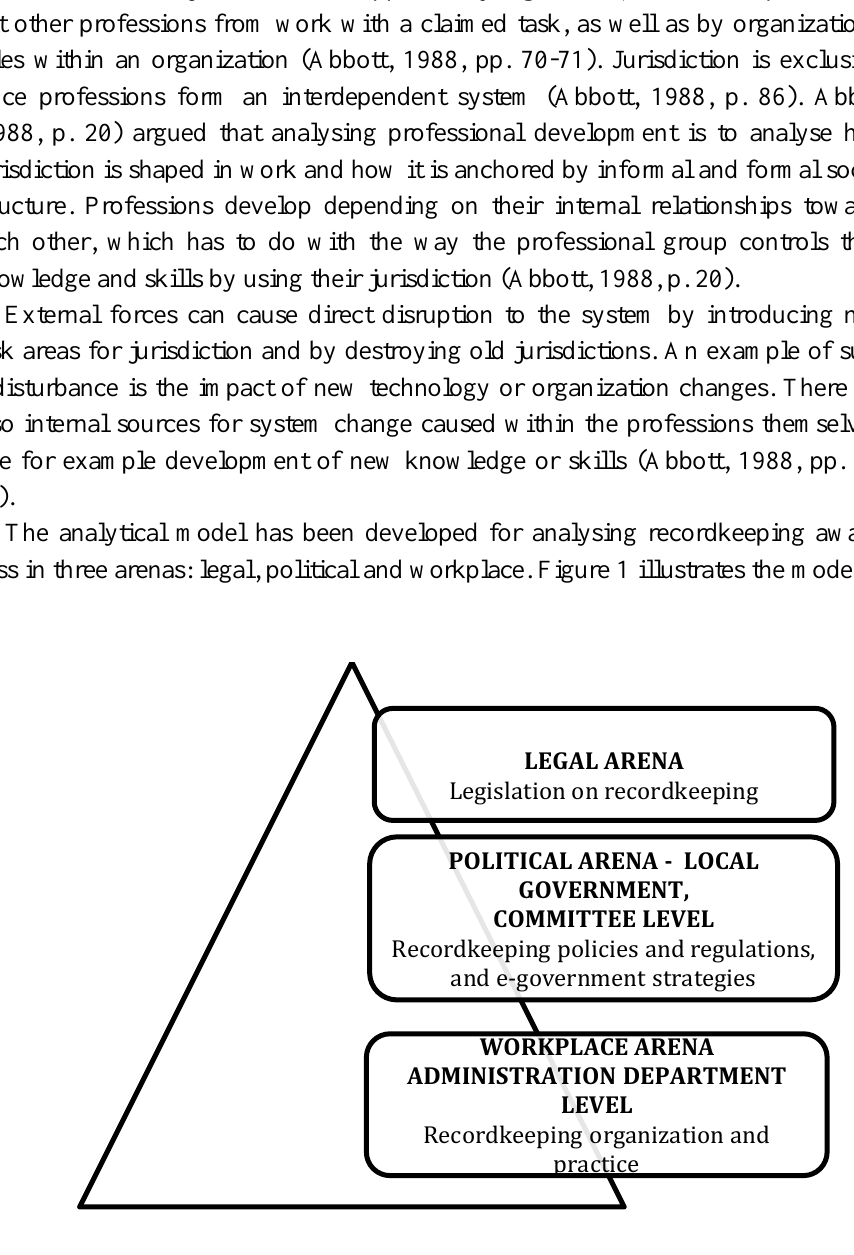
Figure 1. A model for analysing recordkeeping awareness in three arenas The model is hierarchical, in which the legislation arena is on the top, representing the recordkeeping legislation, and the workplace arena on the bottom, representing the practice, which is placed at the administration department level of the local government organizations. The political arena, which is defined as the committee level of the local government organization, is in the middle, in between the legislative and the workplace arena. The politicians are elected by the citizens and therefore represent the